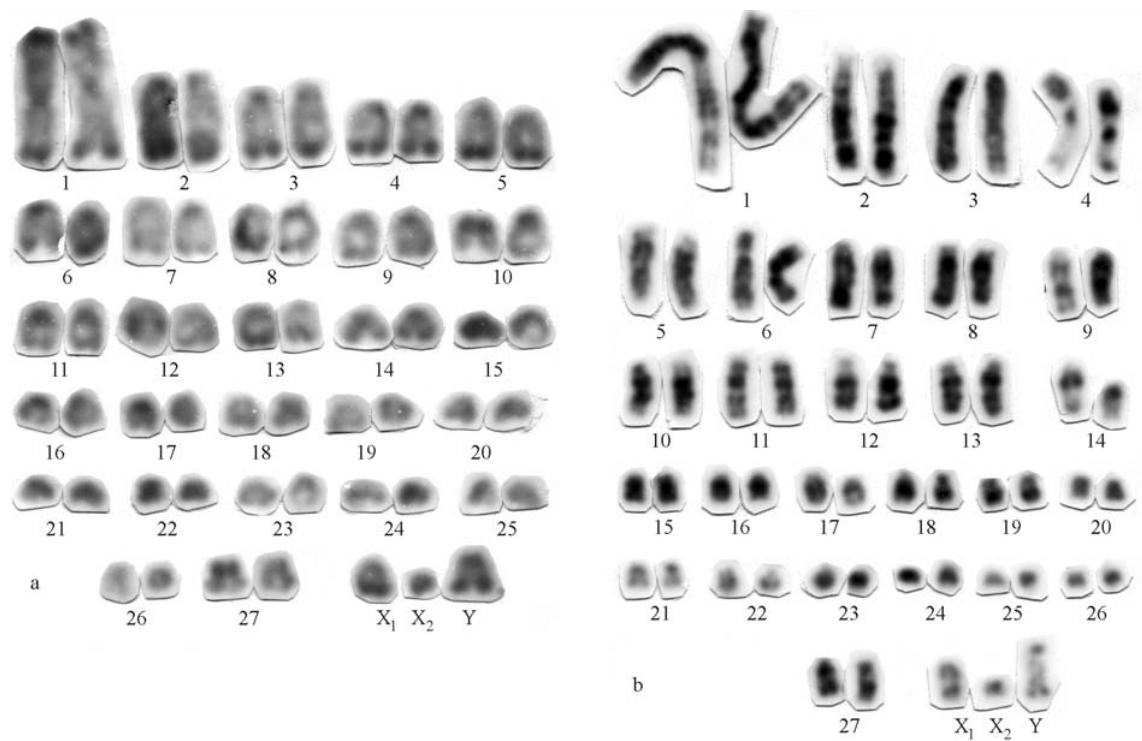
Figure 4 - Banding patterns of Calyptommatus leiolepis (2n = 57). (a) CBG-banding and (b) RBG-banding.